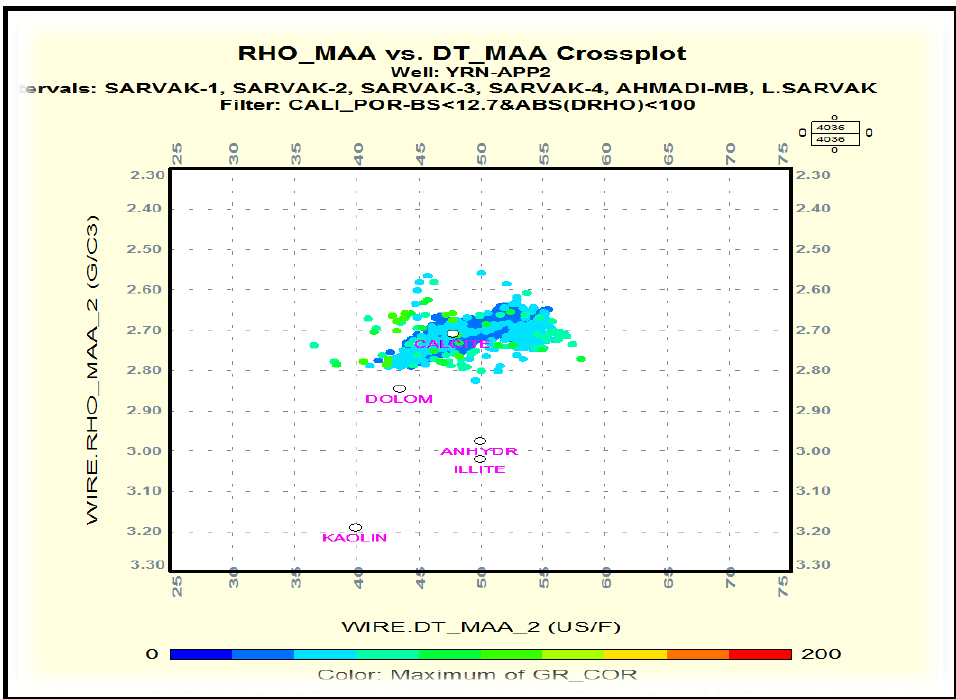
Figure 3. Sound-density cross plot for determining lithology of Sarvak